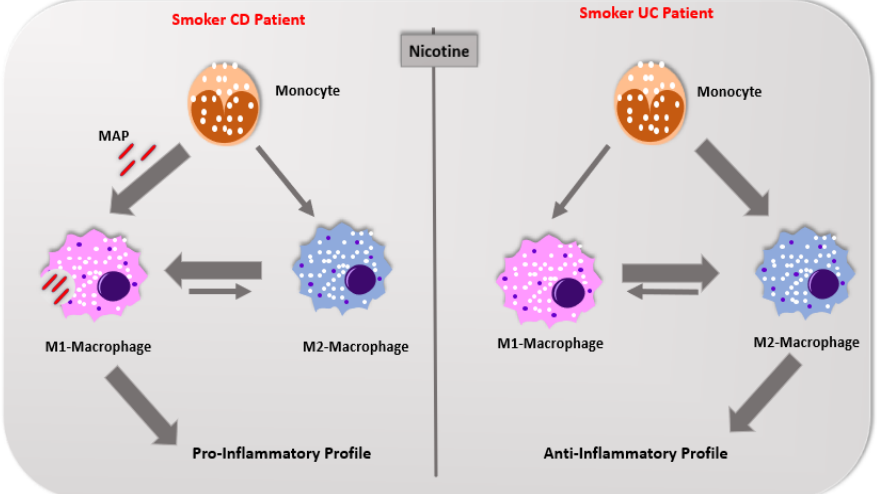
Figure 4. Schematic illustration of the effect of cigarette smoke and nicotine on modulating macrophage polarization in IBD patients.